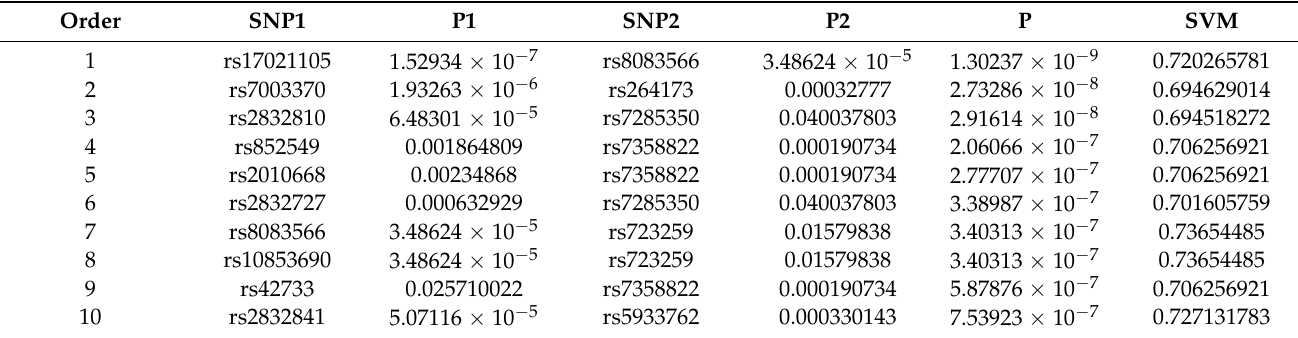
Table 3. Top-10 epistatic interactions associated with